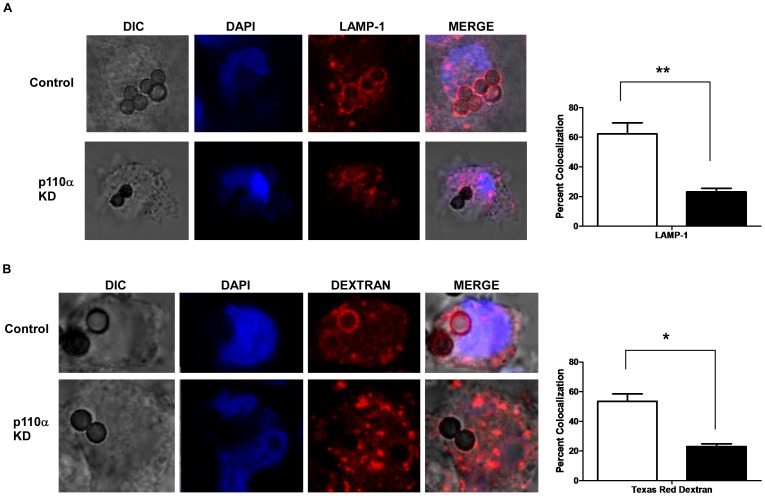
Phagosomes from p110α knockdown cells show marked decreases in LAMP-1 acquisition and phagolysosome fusion.
A) Confocal microscopy of control and p110α knockdown cells shows reduced phagosomal LAMP-1 acquisition. The graph to the right shows counts of phagosomes colocalized with LAMP-1 staining. At least 100 phagosomes in each of three independent experiments were counted. Open bar  =  Control cells, Solid bar  =  p110α knockdown cells. Means +/− s.e.m. are shown. **p<0.01. B) Confocal microscopy of control and p110α knockdown cells shows reduced phagosome - lysosome fusion. Cells were loaded with Texas Red dextran, which was then chased into lysosomes. The graph to the right shows the numbers of phagosomes that were positive for a dextran signal. At least 100 phagosomes in each of three independent experiments were counted. Open bar  =  control cells, Solid bar  =  p110α knockdown cells. Means +/− s.e.m. are shown. *p<0.05.